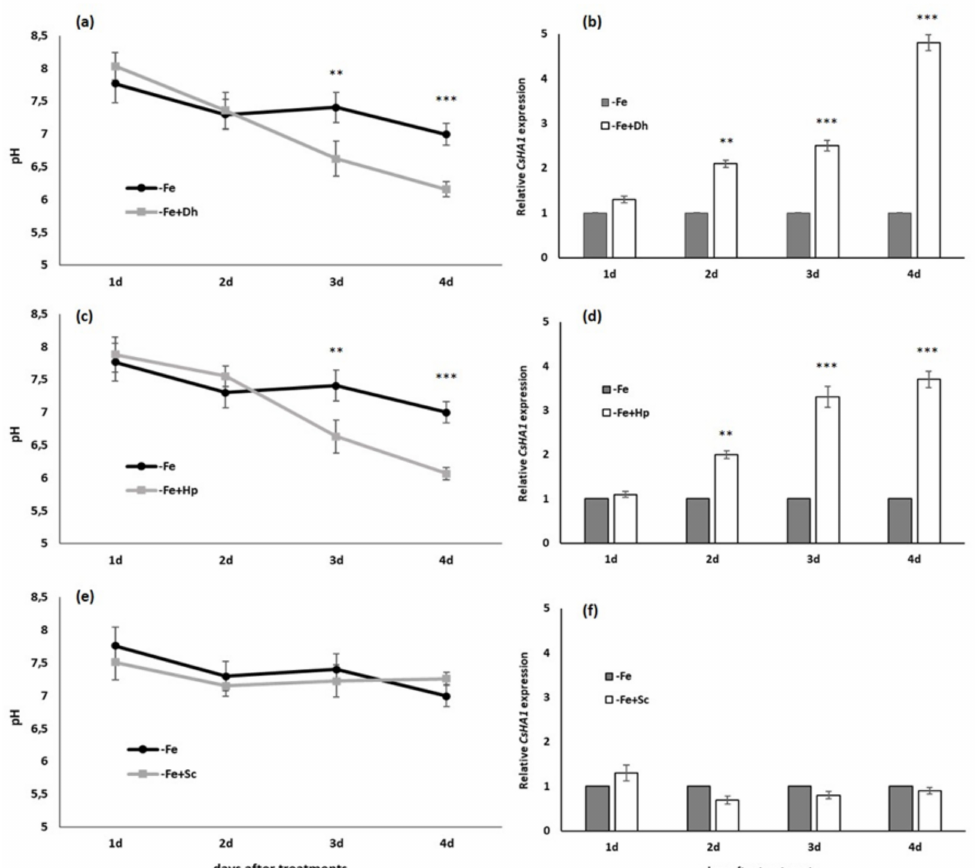
Figure 2. Time course of the pH of the nutrient solution and CsHA1 expression in cucumber plants over the 4 days of treatments. Treatments: (control) without Fe (-Fe) and (inoculated) inoculation with different yeasts, Debaryomyces hansenii ( − Fe+Dh) ( a,b ), Hansenula polymorpha ( − Fe+Hp) ( c,d ), or Saccharomyces cerevisiae ( − Fe+Sc) ( e,f ). The inoculation was carried out on the same day that Fe-deficiency treatment was applied. Data of pH are given as means ± SE ( n = 6). The data of CsHA1 expression represent the mean ± SE of three independent biological replicates and two technical replicates. Within each day, bars with ** or *** indicate significant differences ( p < 0.01 or p < 0.001) in relation to the –Fe treatment according to the Dunnett’s